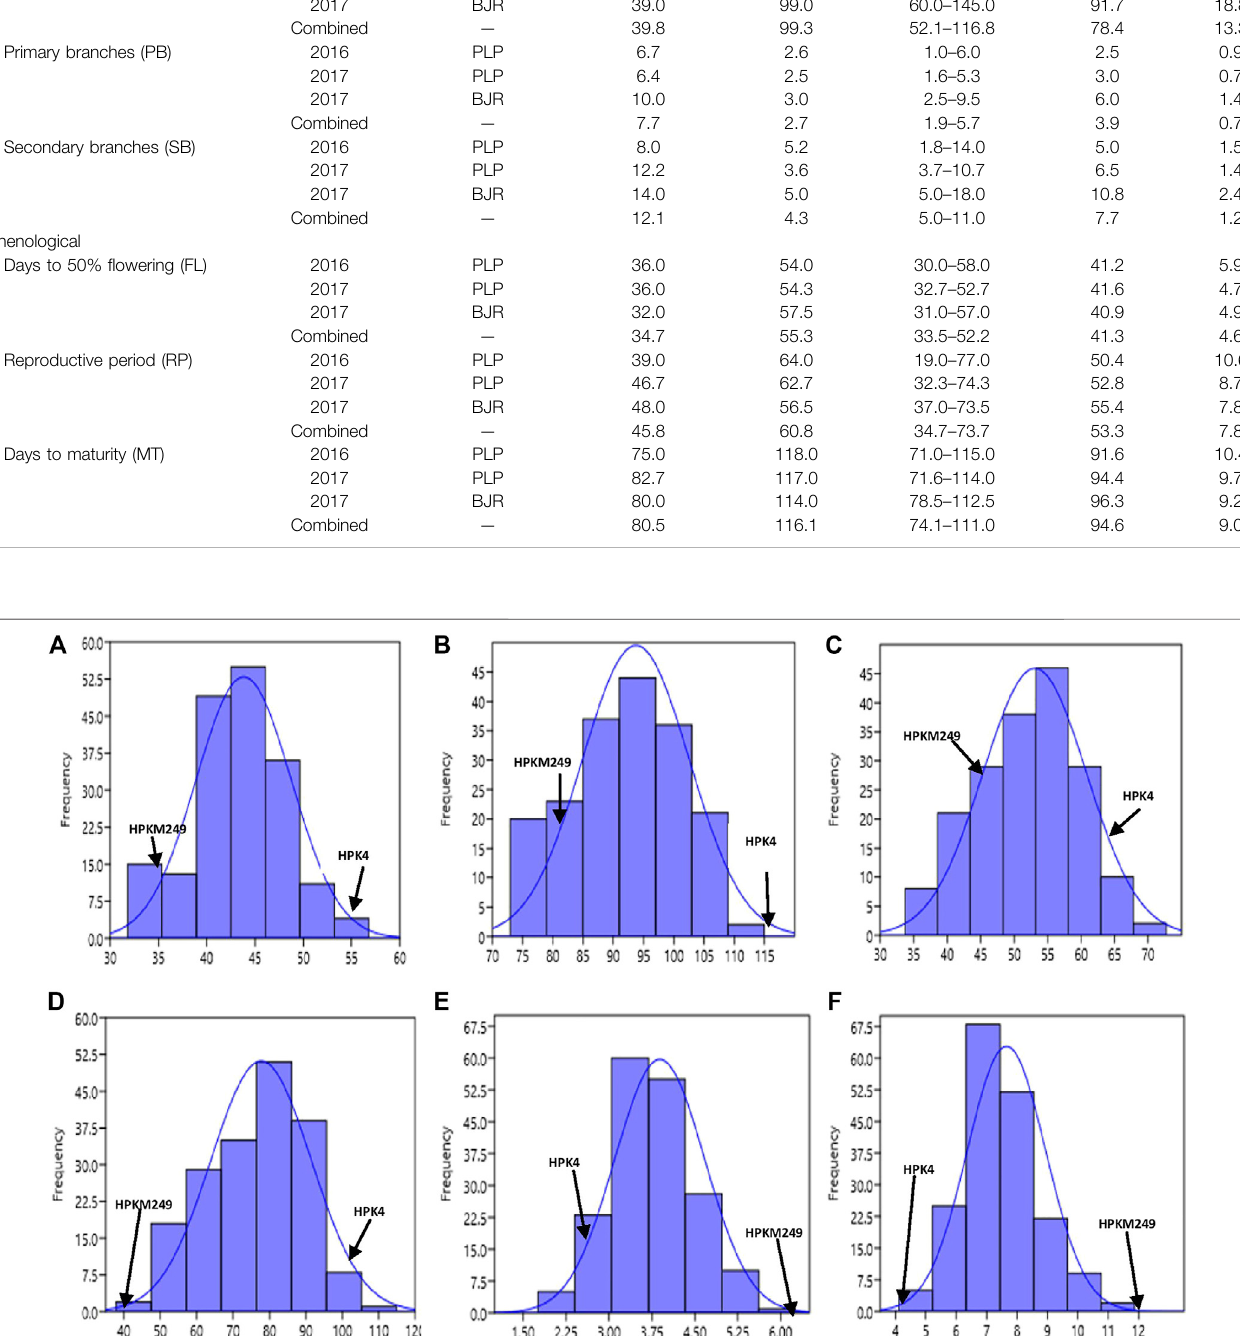
Frontiers in Genetics |